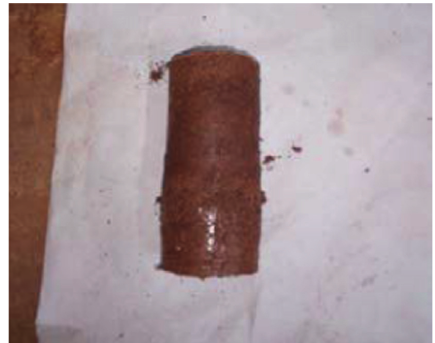
Figure 4: Bulging deformation.